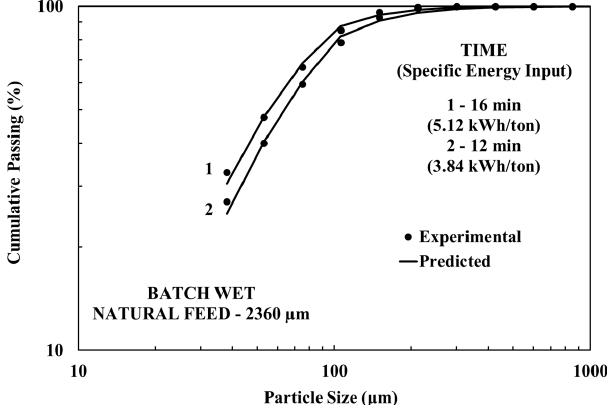
Figure 6. Comparison of experimental product size distribution and “similar fineness of grind” prediction for batch grinding test at 76% of solids and 100% of slurry filling.